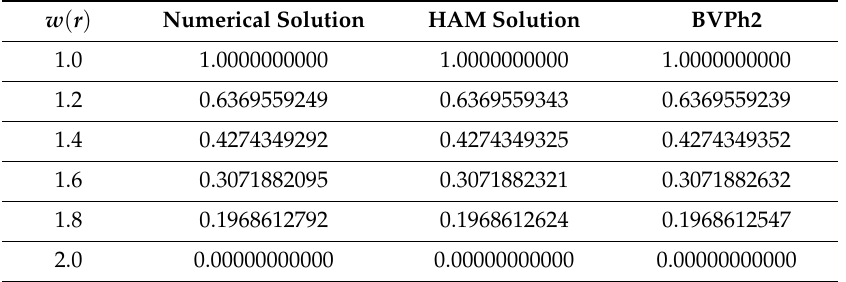
Table 1. Comparison of numerical, HAM, and BVPh2 methods for velocity profile.